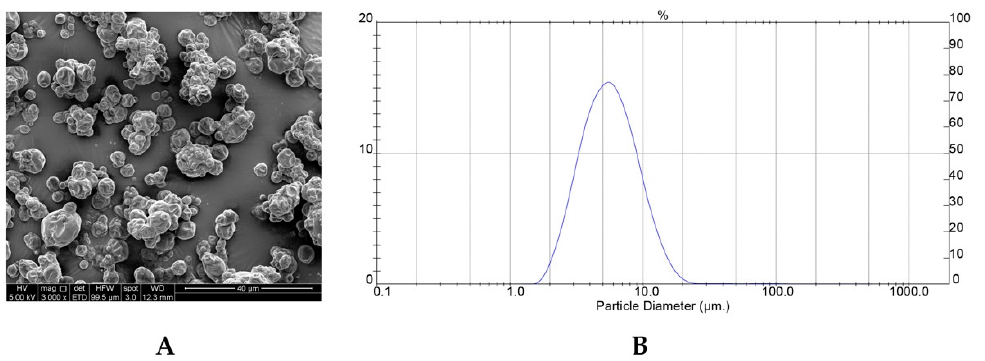
Figure 2. Scanning electron microscopic (SEM) photograph for PPE-MD (S) ( A ) and Particle size distribution ( B ).